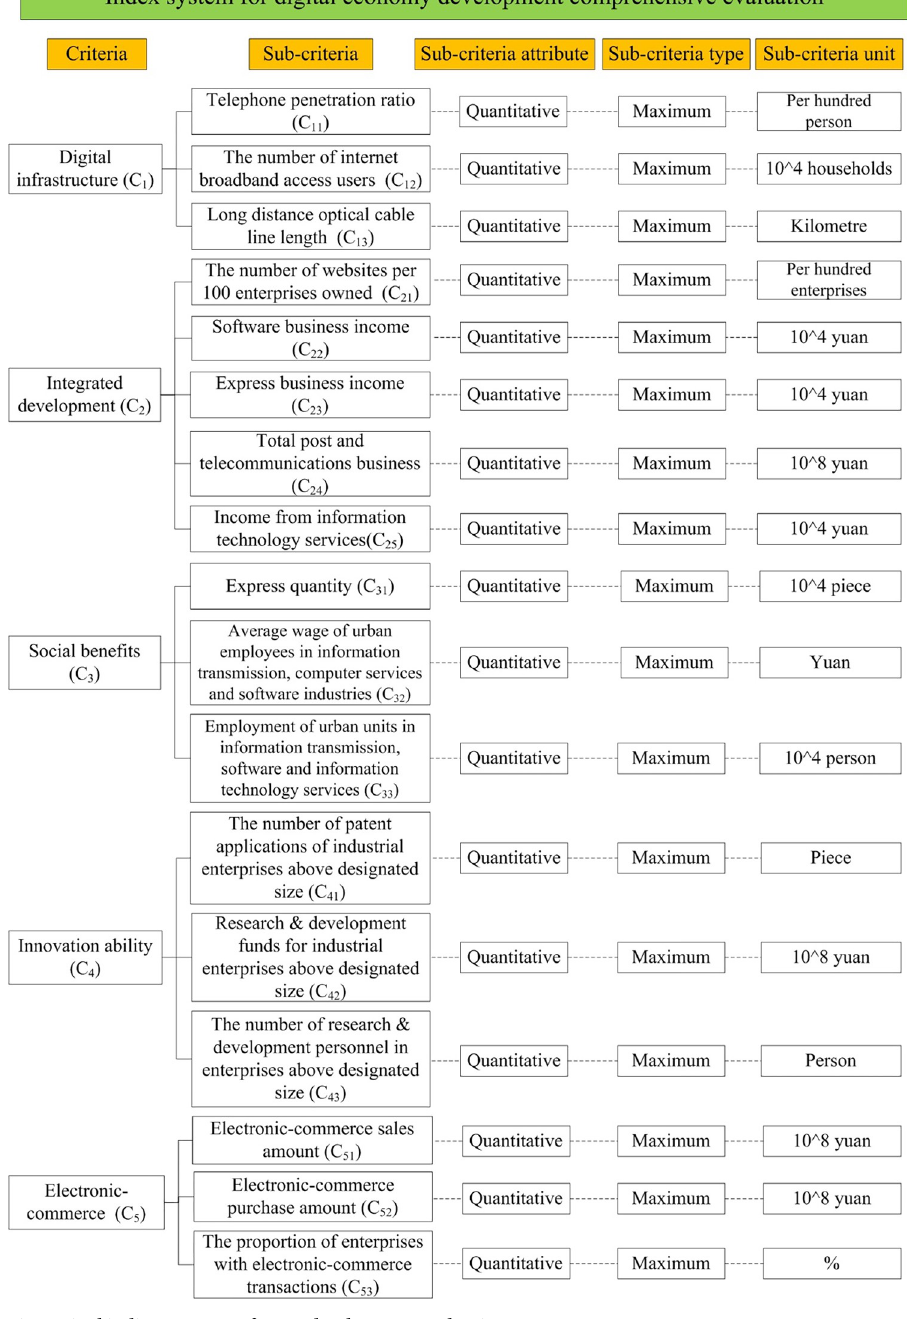
Fig 2. Final indicator system for DE development